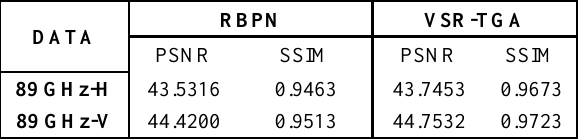
Table 1. Quantitative evaluation of RBPN and VSR-TGA SR results.